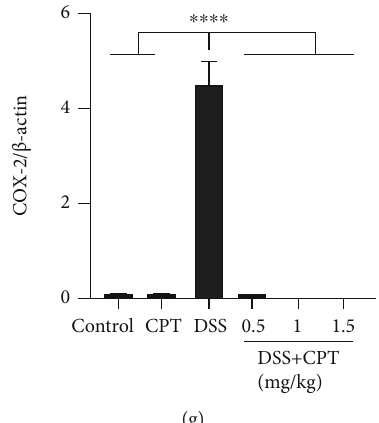
Figure 3: E ff ects of camptothecin (CPT) on the in fl ammatory response of DSS-induced ulcerative colitis (UC) in mice. (a) Myeloperoxidase (MPO) activity assay. The protein levels of (b) IL-1 β , (c) IL-6, and (d) TNF- α were detected using ELISA. Western blot assay of (e, f) inducible nitric oxide synthase (iNOS) and (e, g) cyclooxygenase-2 (COX-2). The relative protein levels were quanti fi ed by scanning densitometry and normalized to the protein level of β -actin. Values are presented as mean ± SD ( ∗ P < 0 : 05 , ∗∗ P < 0 : 01 , and ∗∗∗∗ P < 0 : 0001 vs. the DSS group).